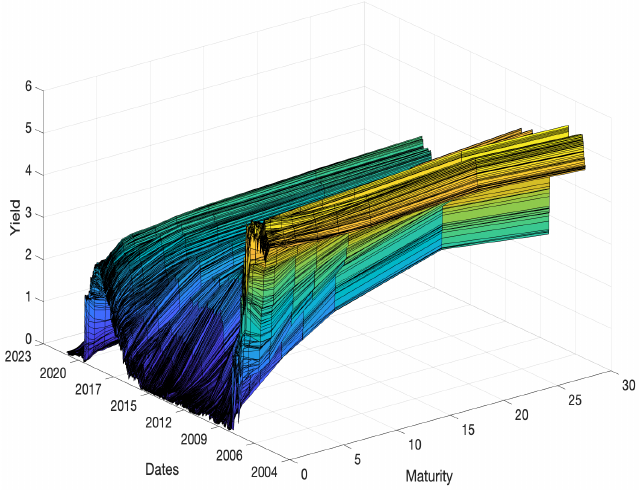
Figure 1. US term